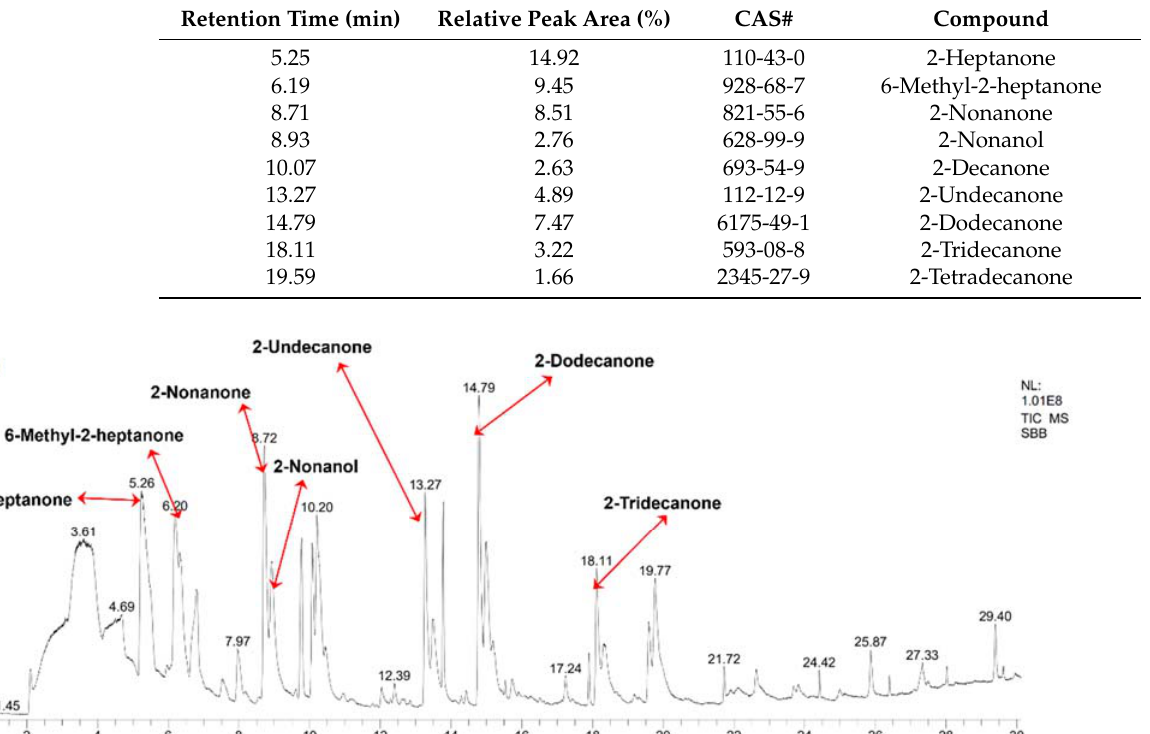
Table 3. GC–MS/MS VOC profile of Bacillus velezensis SBB.